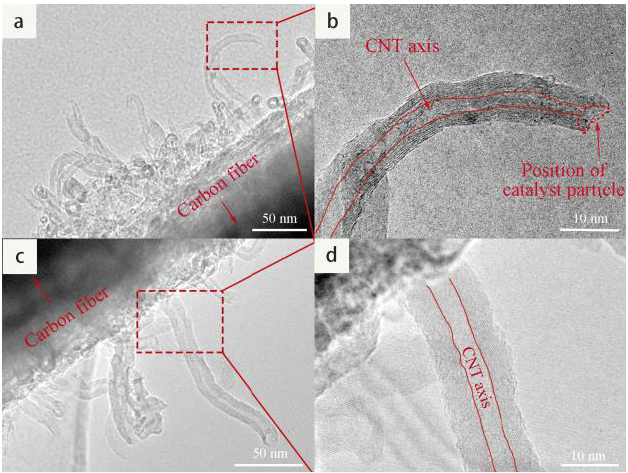
Figure 9. HRTEM images of CNTs grafted on the samples: 4 cm/min and H 2 :C 2 H 2 = 0.3:0.3.